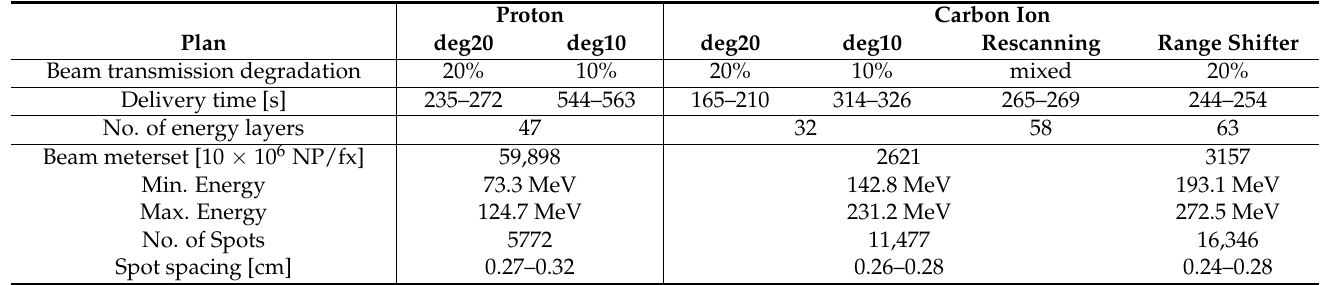
Table 1. Delivery time and number of energy layers and spots, as well as energy range and number of particles per fraction for the different proton and carbon ion treatment plans. The delivery time during a measurement day varied by around 2 s, while the delivery time in the table shows the variation between the different measurement